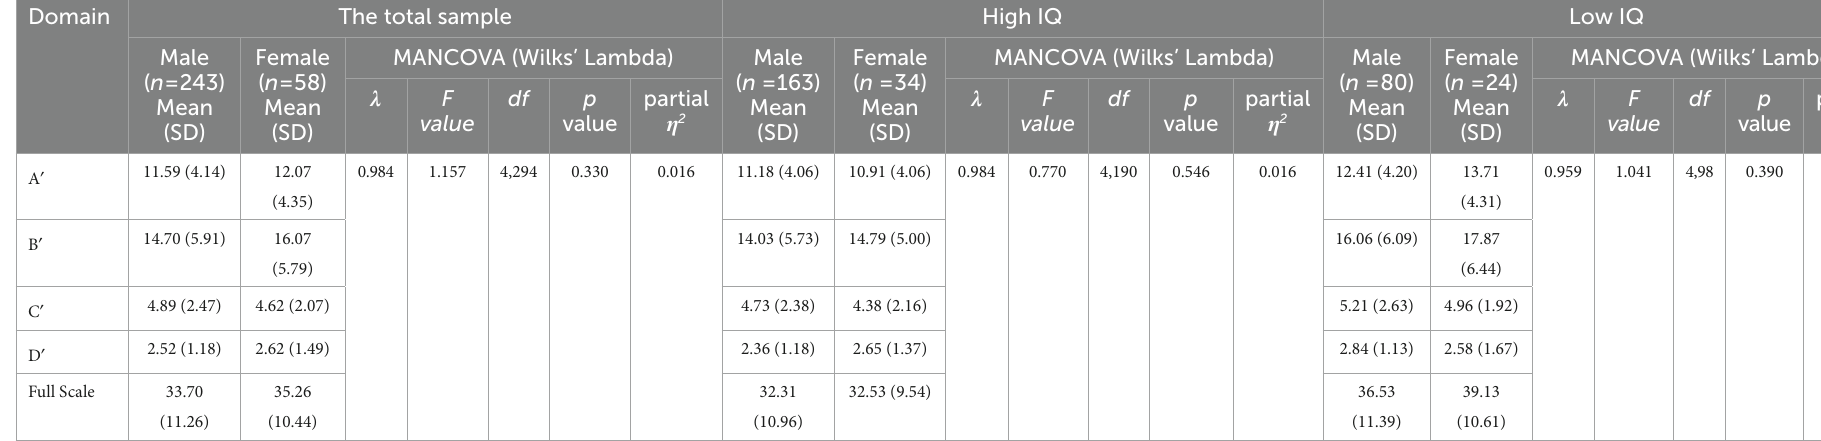
TABLE 6 Sex differences among children with ASD in the domain scores of ADI-R. Domain